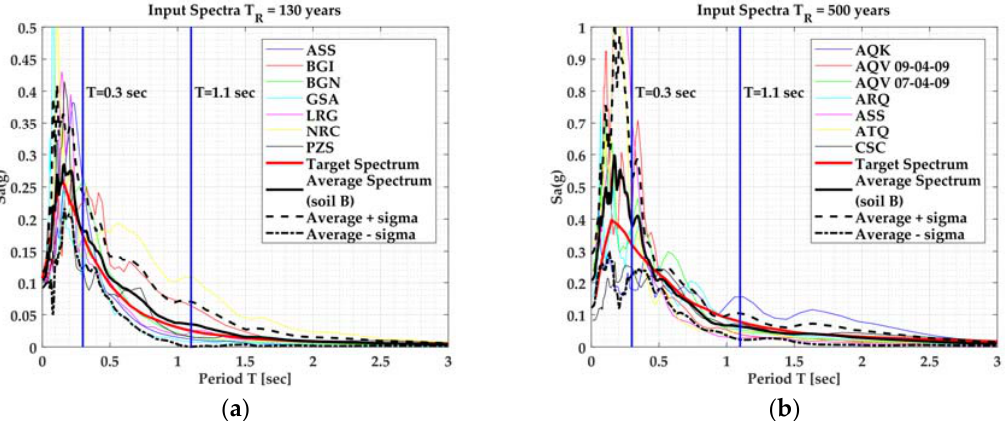
Figure 8. Average response spectrum. Spectrum ‐ compatibility is assumed between 0.3–1.1 s. ( a ) Return period = 130 years; ( b ) return period = 500 years.